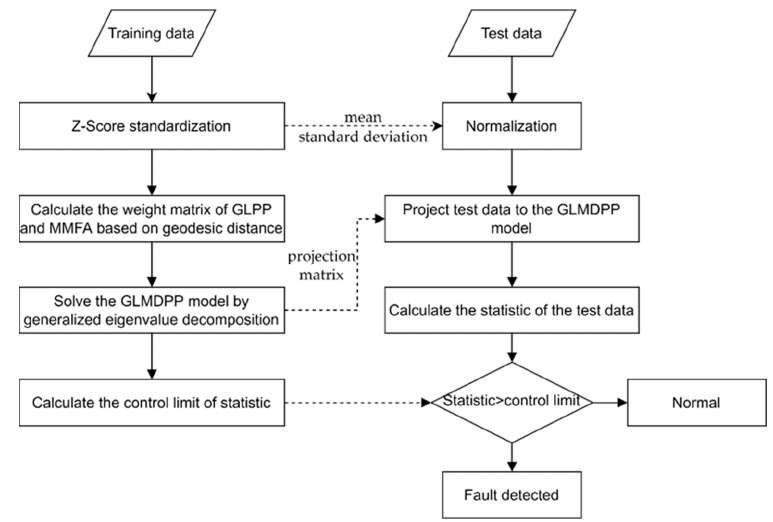
Figure 1. Fault detection procedure based on GLMDPP algorithm. Offline